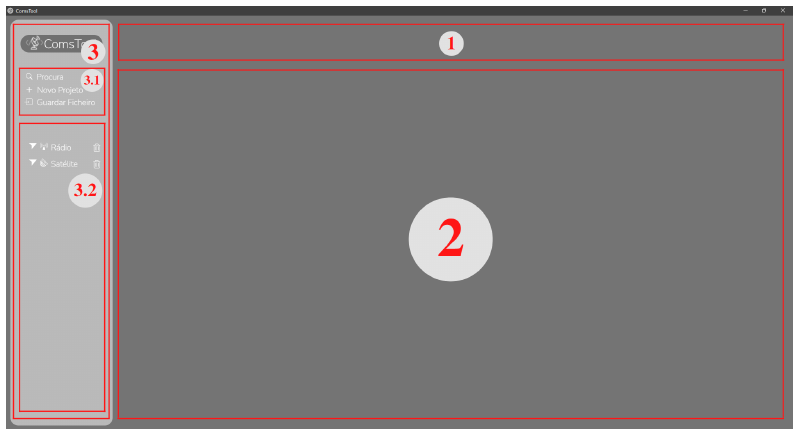
Figure 2. The developed tool’s main